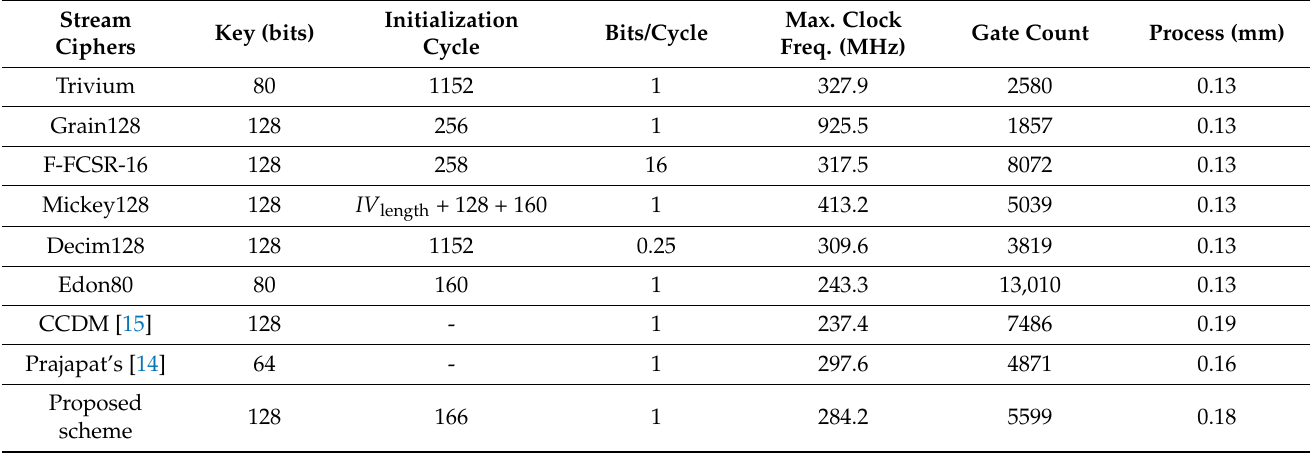
Table 12. Performance comparison with some stream